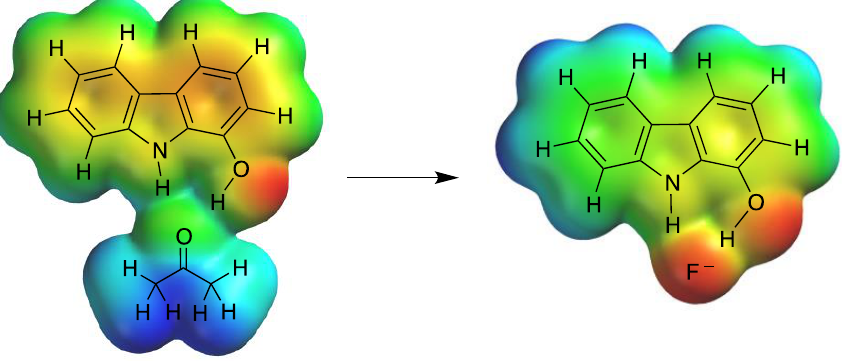
Figure 7. Electron density surface calculated for 2c associated with the solvent (acetone) and fluo- ride.